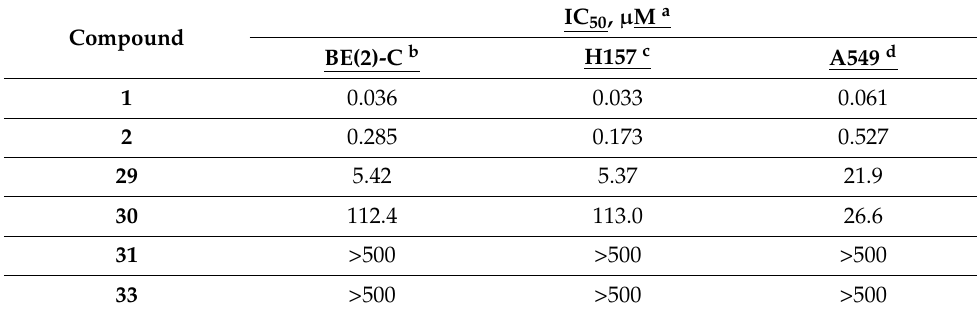
Table 1. Results of biological